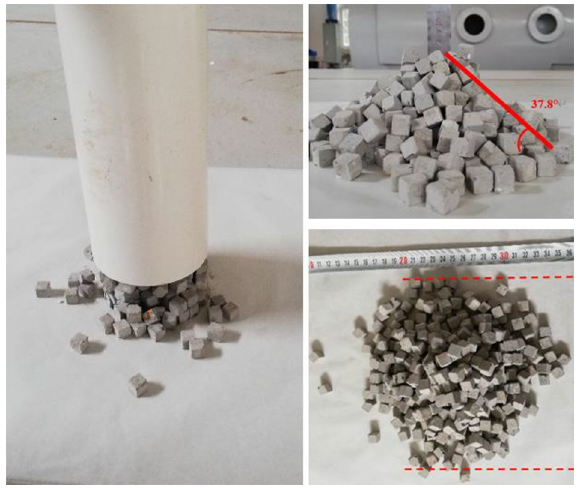
Figure 10. The angle of repose test.